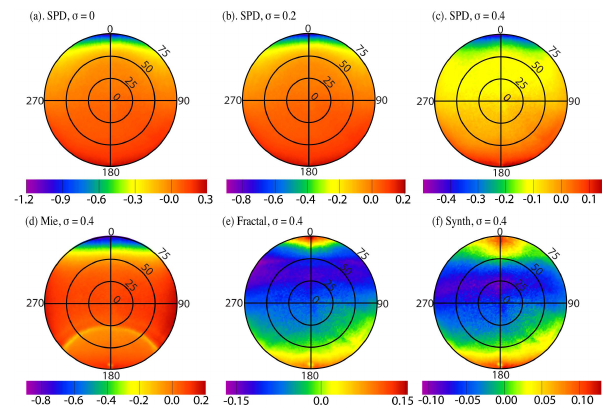
Fig. 7a–f. Difference between derived CAR BRF in the red band and modeled BRF ( R new ) for different slope distribution functions. All images show differences with CAR red band BRF for 7 April flight over Elson